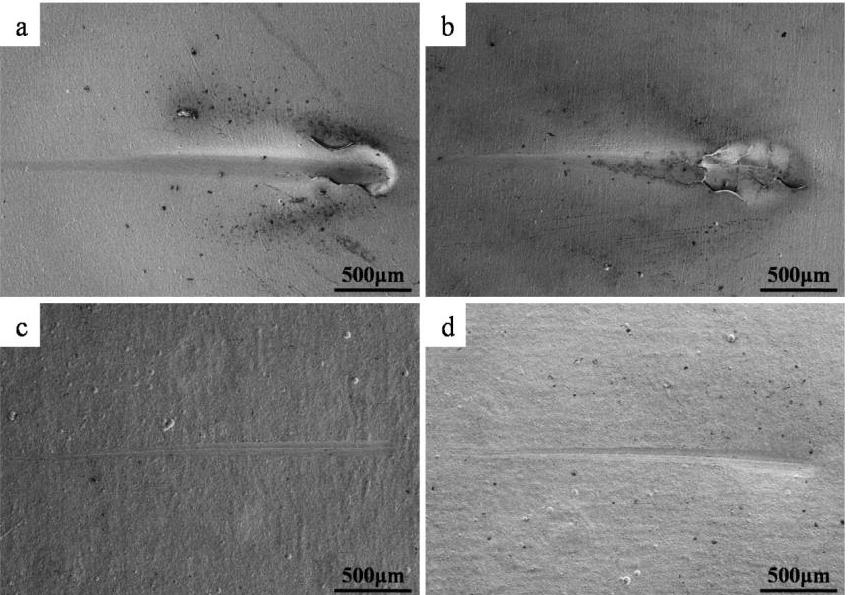
Figure 6. Morphologies of the coatings ’ scratch: ( a ) traditional pretreatment coating; ( b ) 10% laser energy density cleaning coating; ( c ) 20% laser energy density cleaning coating; ( d ) 30% laser energy density cleaning coating.